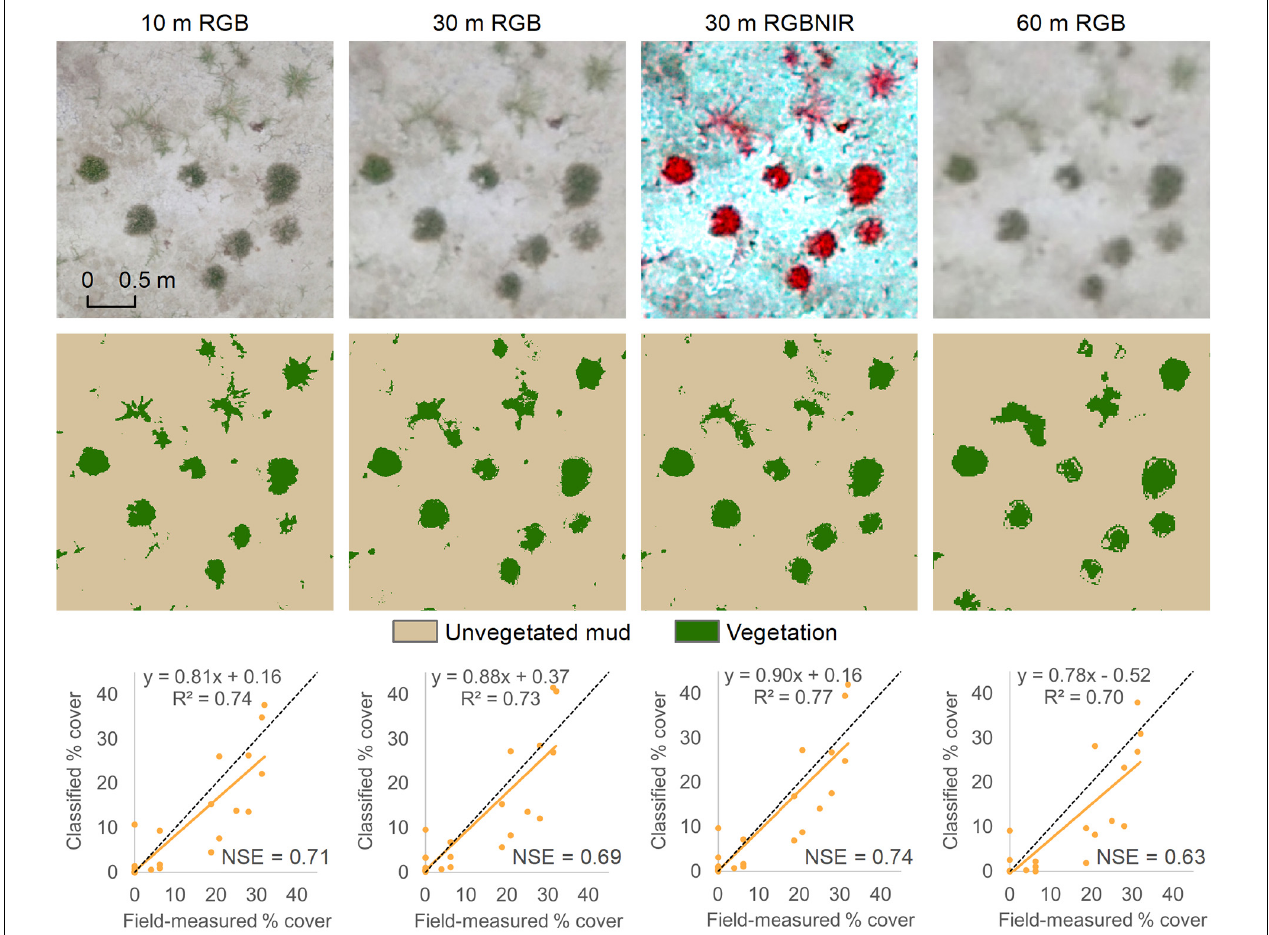
FIGURE 3 | UAV imagery, classified vegetation, and percent cover accuracy assessments for three different flight altitudes (10, 30, and 60 m). Visible spectrum (RGB) imagery is shown in true color, while the imagery including visible and near-infrared bands (RGBNIR) is shown in false color. Accuracy was assessed by comparing percent cover of classified vegetation with field-measured cover in 24 plots and calculating the Nash-Sutcliffe Efficiency (NSE) coefficient, which measures closeness to the 1:1 (dashed) line.